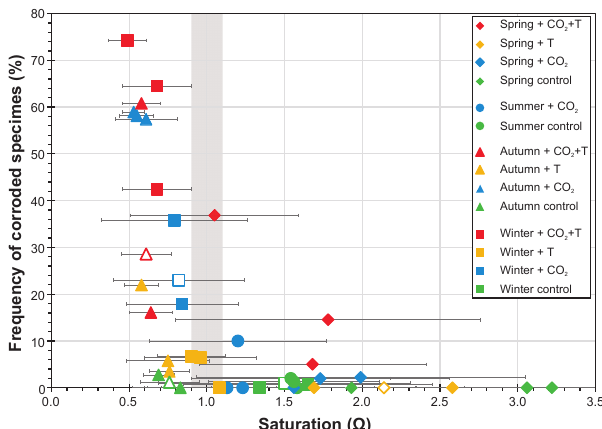
Figure 10. Proportion of corroded samples as a function of the cal- cium carbonate saturation state of seawater. Each data point repre- sents one basin. Grey bar indicates saturated water ( (cid:127) = 1 . 0 ± 0 . 1). Error bars are standard deviations of saturation data for each basin (Table 1). For basins without available saturation data the treatment averages were used (open symbols).